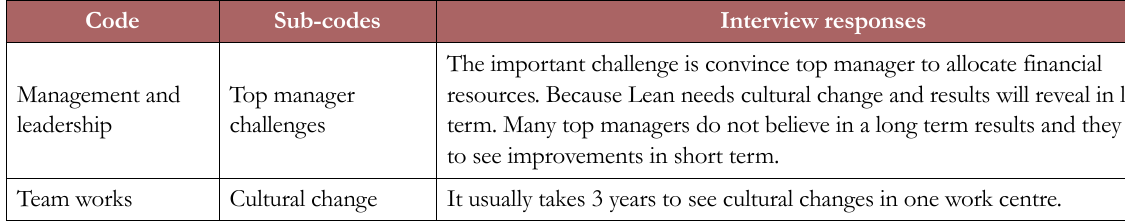
Table 5. Quotes of interviews related to dimension